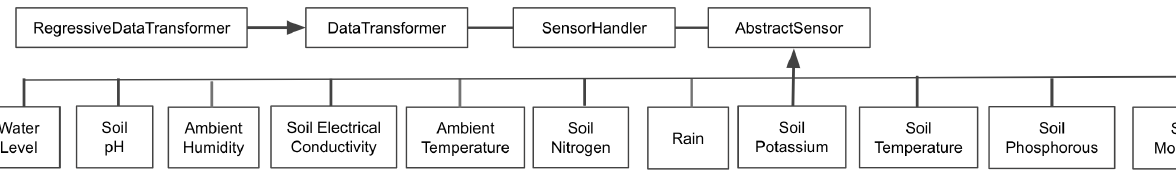
Figure 7. Class diagram of a modular sensor library, showing 11 concrete sensor classes de- rived from the AbstractSensor class, the RegressiveDataTransformer class derived from an abstract DataTransformer class, and the SensorHandler class, which is responsible for the management of the sensors’ sleep-and-wake